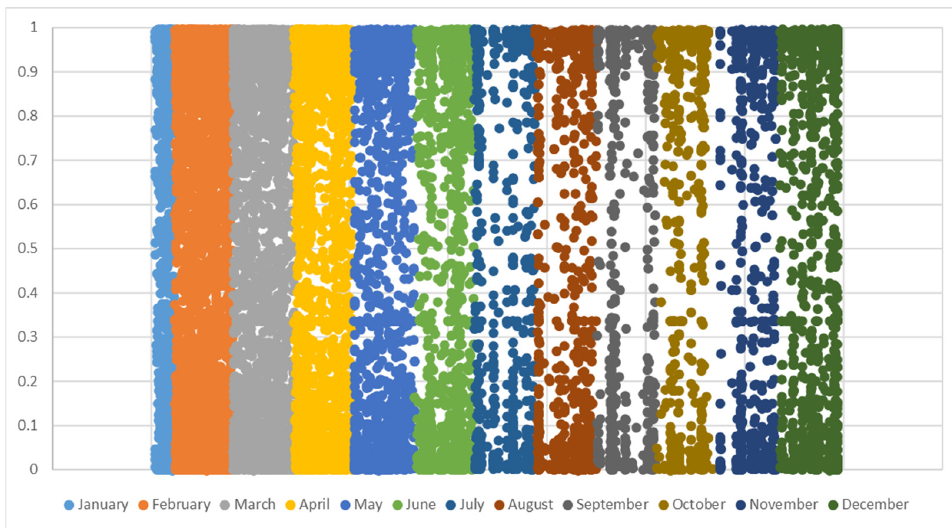
Figure 5. Emotional Tendency Distribution Map.